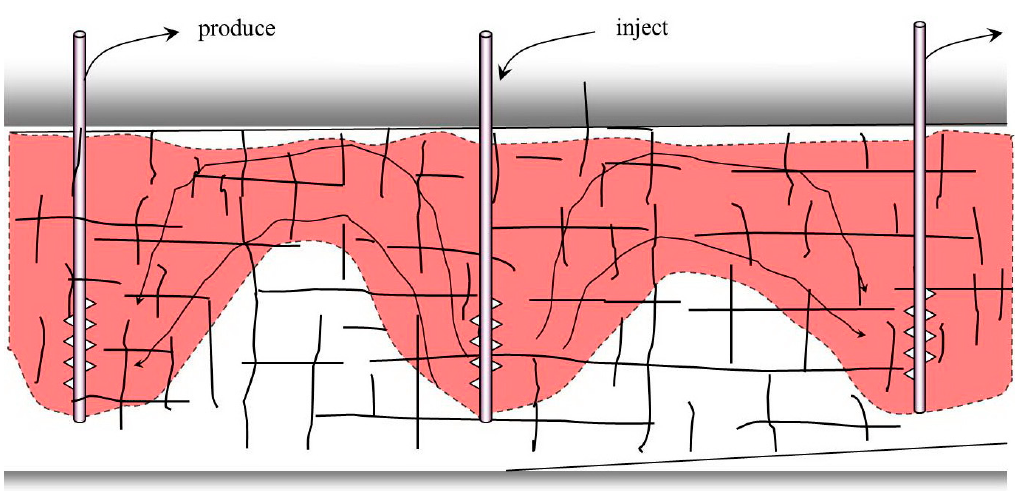
Figure 1. Steamflooding (SF) in NFCRs. This cartoon is a conceptual model of steamflooding in NFCRs taking into account the steamflooding experiences and the understanding we have from similar thermal operations in sandstones and oil sands and various effects such as steam override, and development of steam front. The black arrows show the flow direction and the red color shows the steam saturated zones or heated zones in the reservoir. The process involves continuous injection of steam typically with a row of injectors and the heavy oil that is mobile after heating up the reservoir and the heavy oil is displaced by steam toward production wells [10].